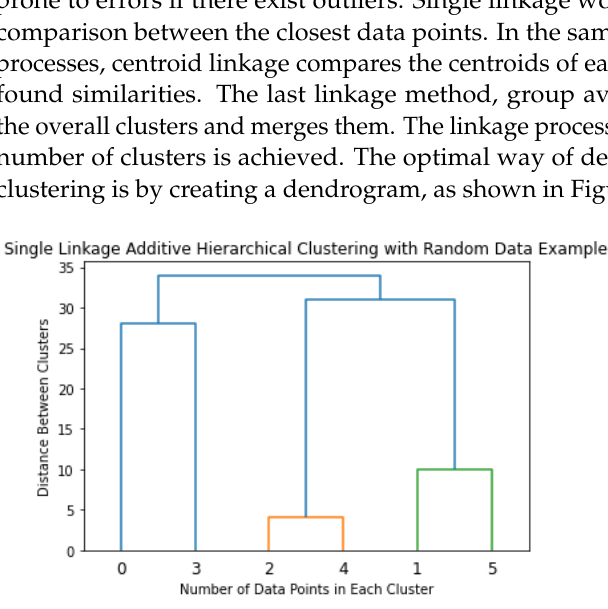
Figure 5. Single Linkage Additive Hierarchical Clustering with Random